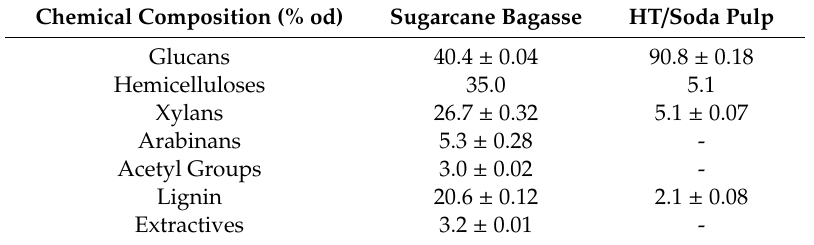
Table 1. The chemical composition of raw material and hydrothermal treatment (HT) / Soda pulp (% oven-dried,